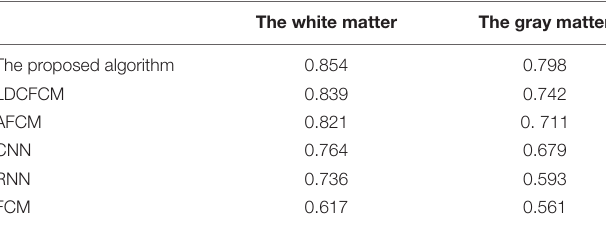
TABLE 2 | Variation of each model with the Jaccard coefficient